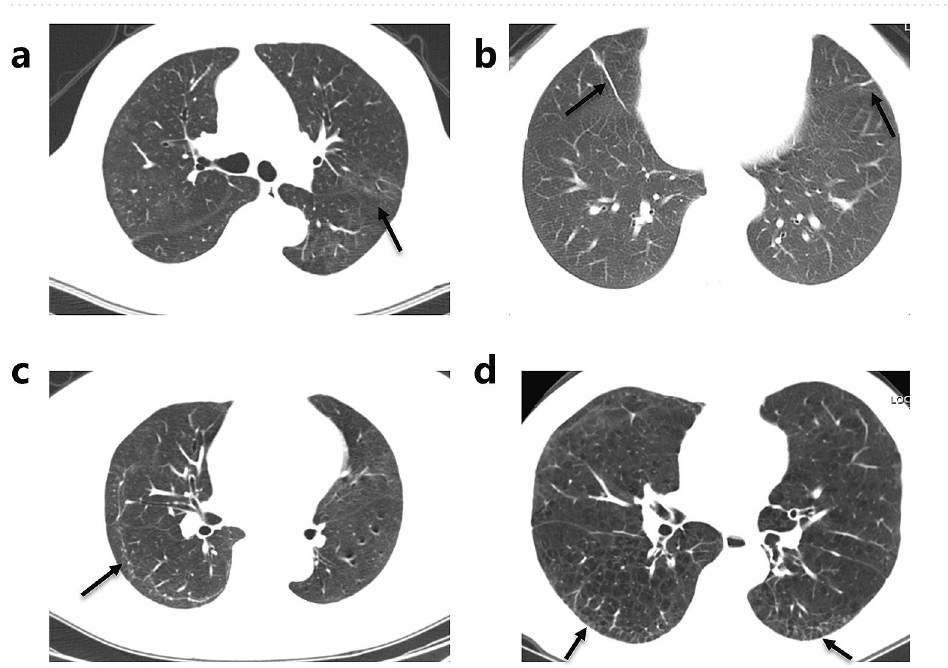
Figure 2. Abnormal CT patterns of severe COVID-19 patient at follow-up of eight months post discharge. The abnormal CT patterns are indicated by arrows in ( a ) ground glass opacities, ( b ) irregular lines, ( c ) subpleural line, and ( d ) reticular pattern which could still be seen on some of COVID-19 patients in convalescence of eight months post